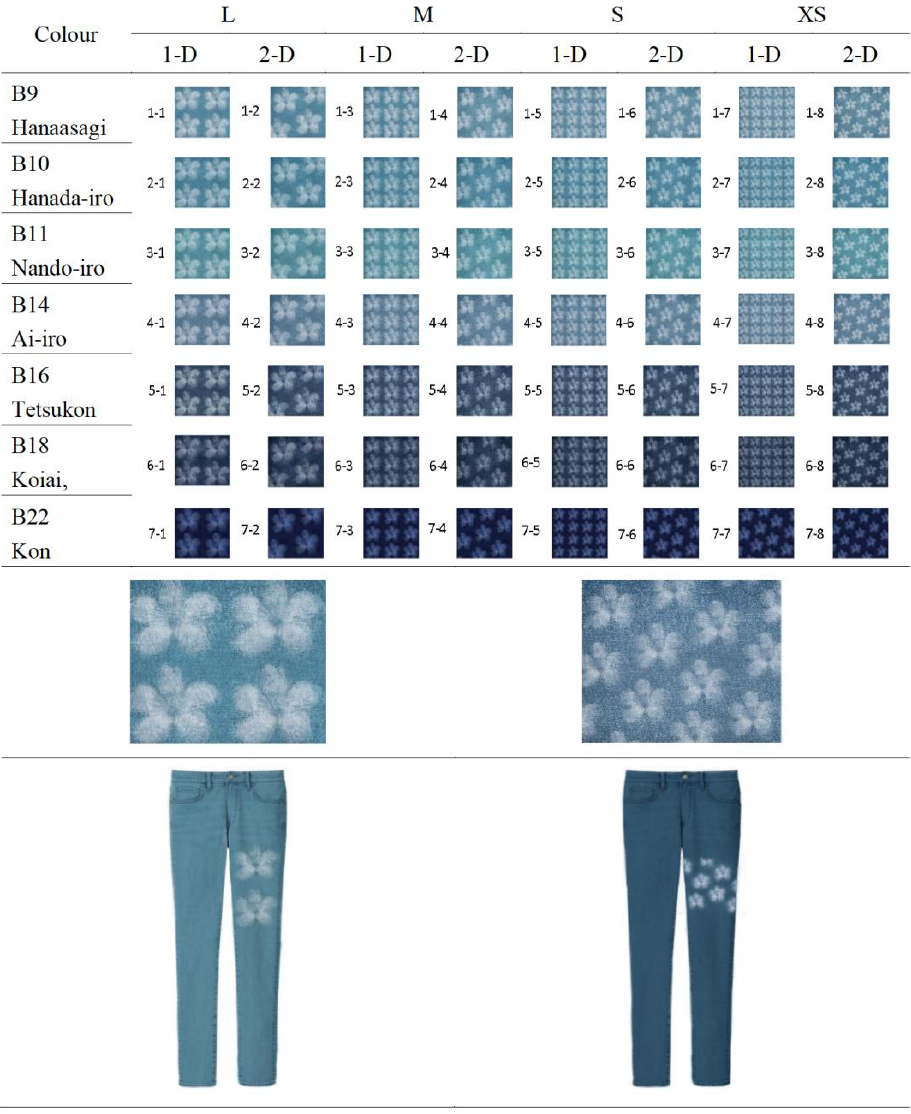
Figure 4. The upper panel shows 56 thumbnails, and the middle panel shows enlarged images of the hyperlinked thumbnails (only 1-1 and 4-6 are shown here). The lower panel shows the